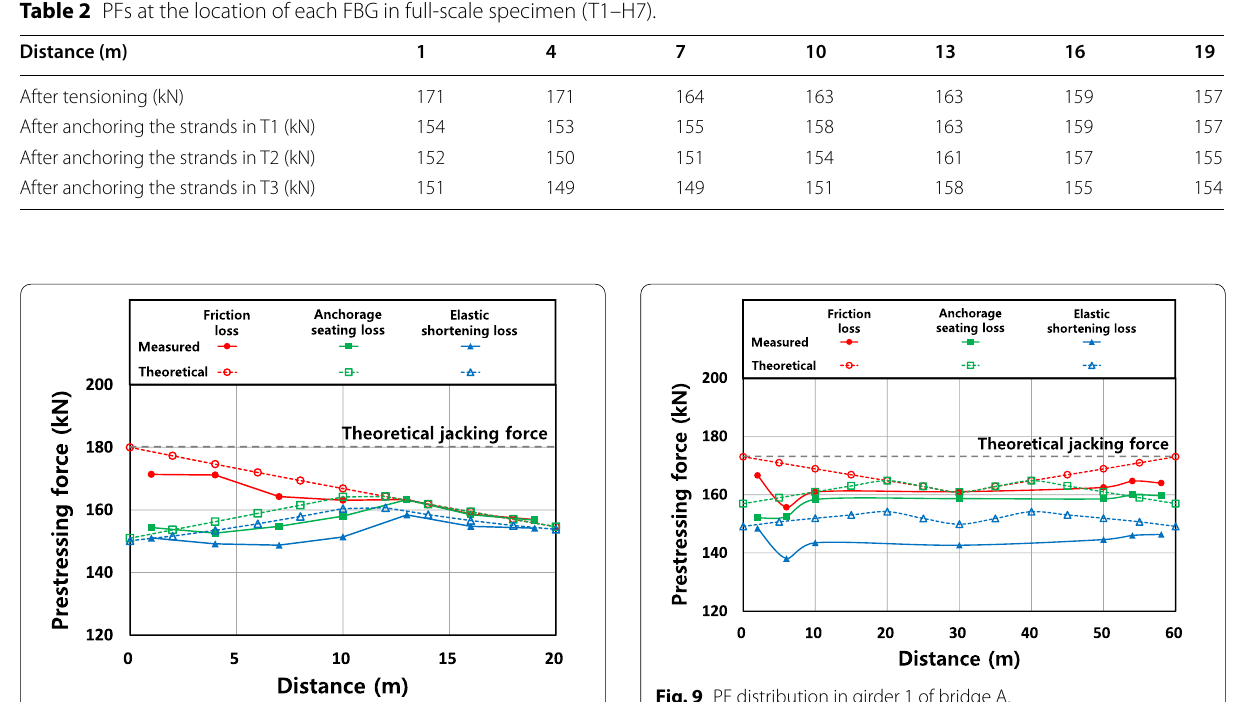
Fig. 8 PF distribution in full‑scale specimen (T1–H7).